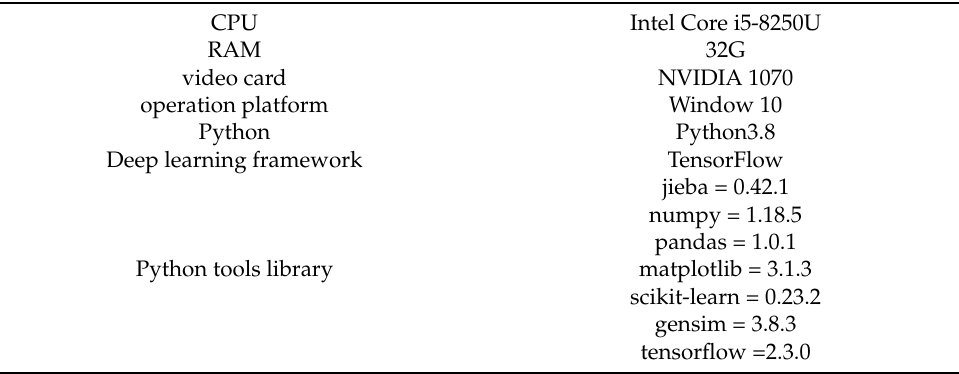
Table 4. Experimental Environment and Configuration.